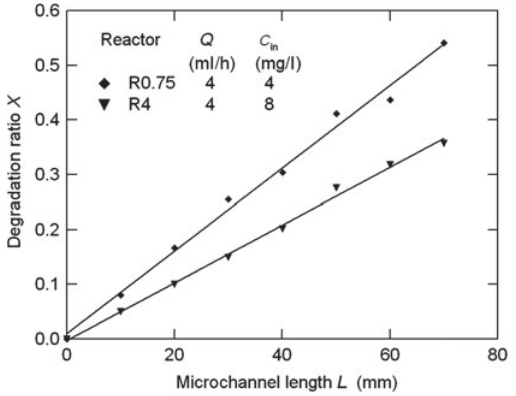
Figure 5 Degradation ratio ( X ) of salicylic acid as a function of the microchannel length ( L ) for different inlet concentrations ( C polymeric reactors. The reactors used are similar in width and height to R0.75 ( w = 1.5 mm and h = 0.75 mm) and R4 ( w = 2 mm and h = 1 mm). The lines represent the best linear fits given by X = 0.0076 L + 0.0097 (R 2 = 0.992) for R0.75, and X = 0.0053 L -0.0026 (R 2 = 0.996) for